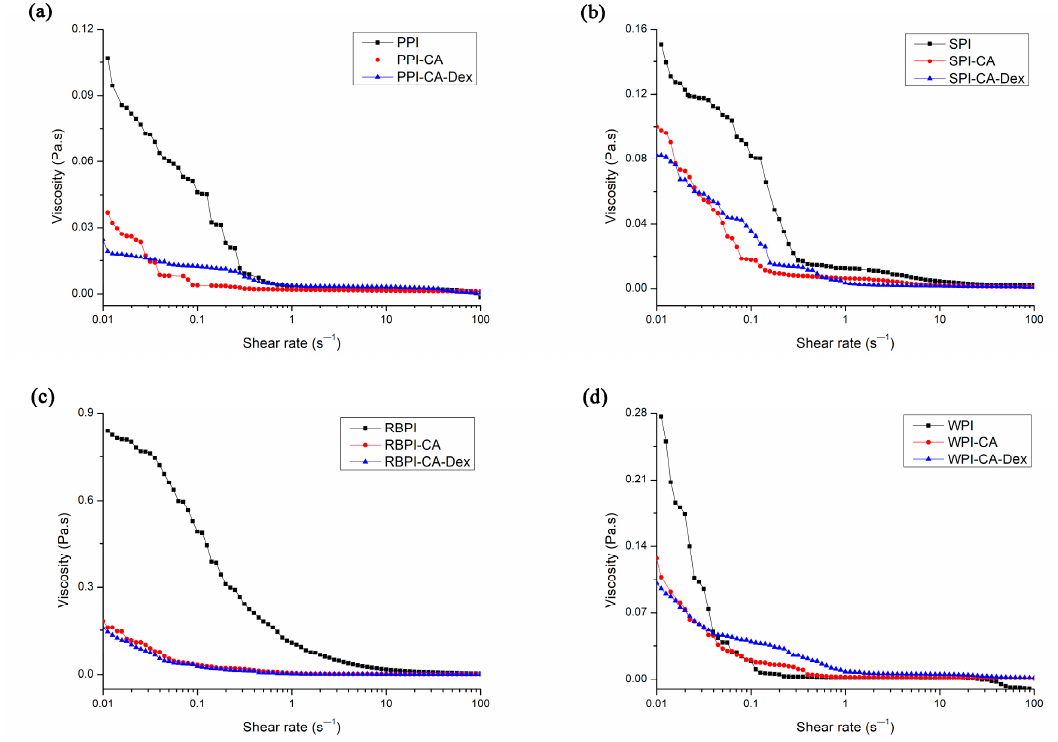
Figure 5. The apparent viscosity of nanoemulsions stabilized by NP, PC, and PCD samples. ( a ) represented the apparent viscosity of nanoemulsions stabilized by PPI, PPI-CA and PPI-CA-Dex; ( b ) represented the apparent viscosity of nanoemulsions stabilized by SPI, SPI-CA and SPI-CA-Dex; ( c ) represented the apparent viscosity of nanoemulsions stabilized by RBPI, RBPI-CA and RBPI-CA-Dex and ( d ) represented the apparent viscosity of nanoemulsions stabilized by WPI, WPI-CA and WPI-CA-Dex.